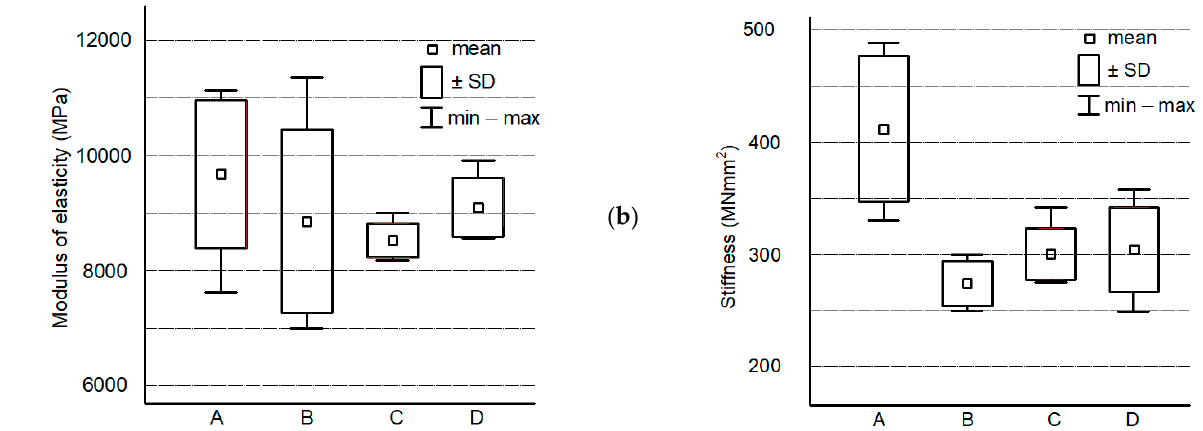
Figure 8. Results of fatigue in bending after air conditioning under conditions of 22 °C and 10% air humidity: ( a ) MOE; ( b ) stiffness.